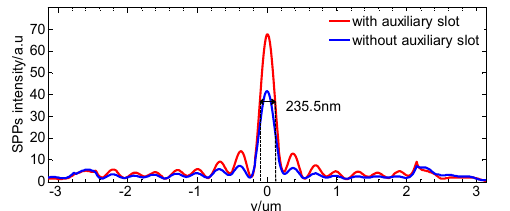
Figure 4. The intensity profile of the hot spot along y-axis in the center of the surface plasmonic lens with and without the auxiliary spiral slot illuminated by a left polarized light, w 1 = 310 nm, w 2 = 155 nm, h 1 = 110 nm, h 2 = 45 nm, r 0 = 2000 nm, m = 1, λ = 633 nm.